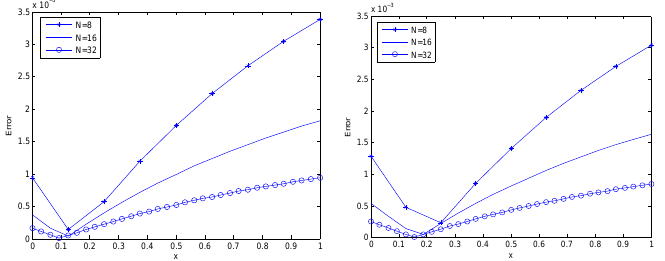
Figure 2. Point wise absolute error of Example 1 and Example 2 respectively at ε = 10 − 20 with different mesh points N .